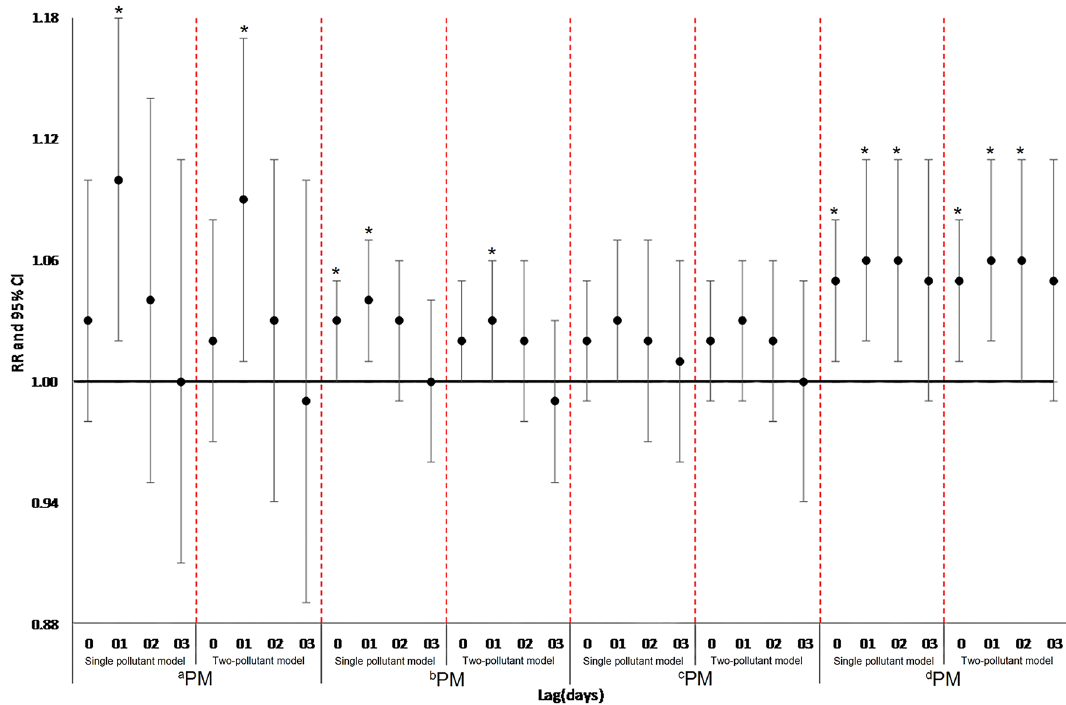
Figure 3. Lag structures of relative risk (RR) and 95% confidence interval (CI) between single pollutant models and two-pollutant models for different PM 2.5 ranges in lag 0 to lag 03. a 0–35 μg/m 3 , b 35–75 μg/m 3 , c 75–115 μg/ m 3 , d 115–150 μg/m 3 . *p <